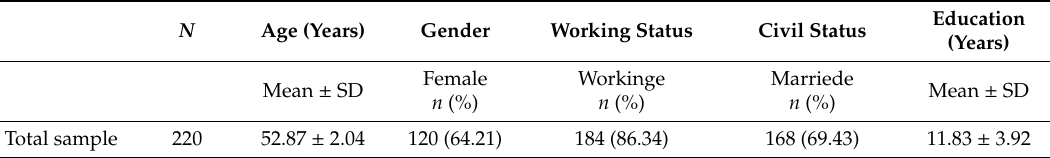
Table 1. Demographic Characteristics of the